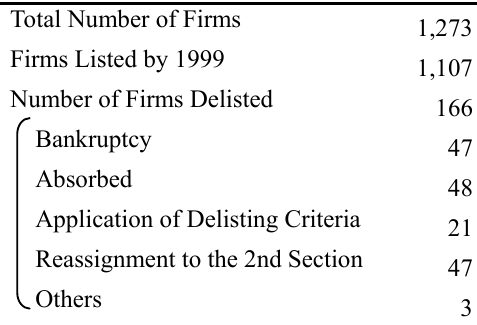
Table 1. Composition of the Data